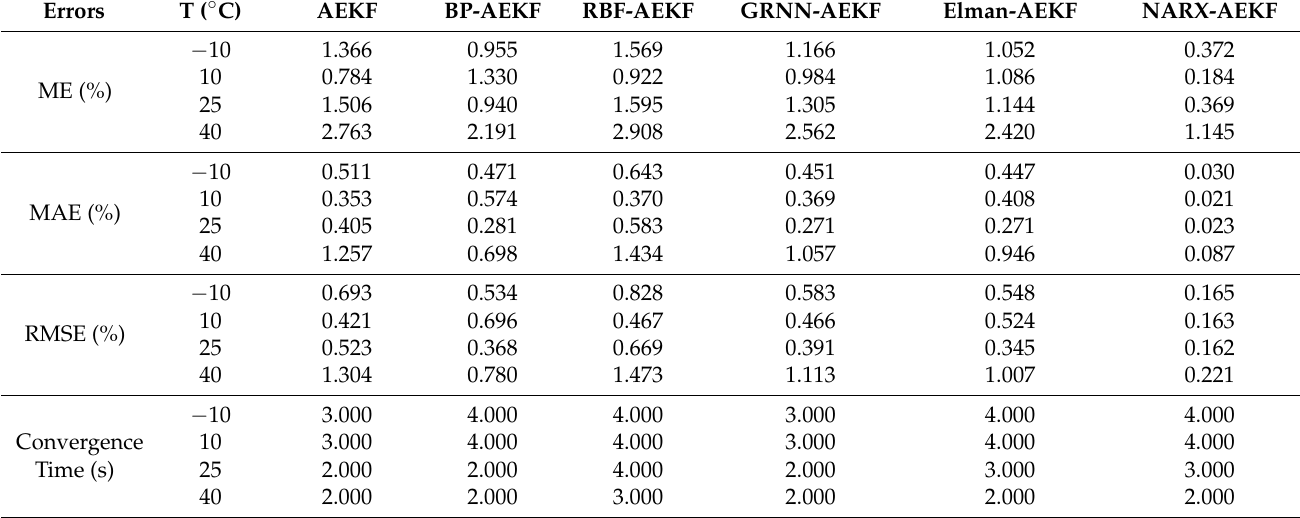
Table 7. The error and convergence time statistics of different SOC estimation